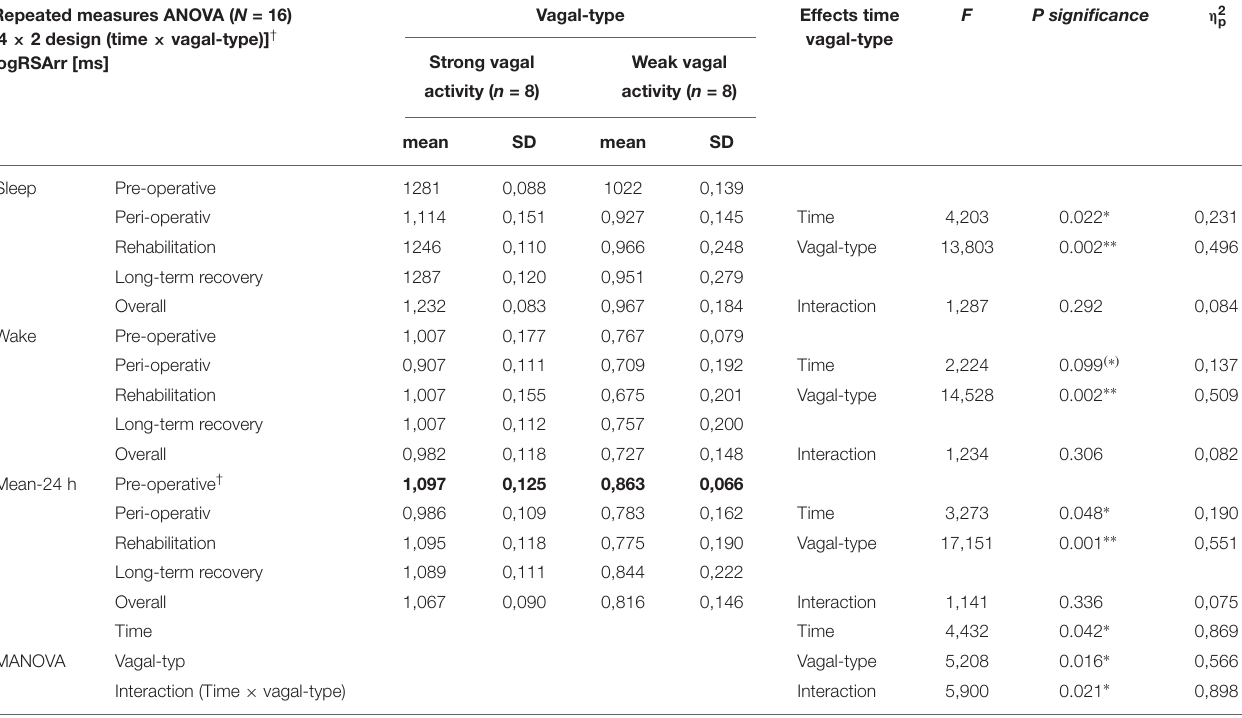
TABLE 2 | Statistical analysis for interaction (time × vagal-type) according ( Figures 2 , 3